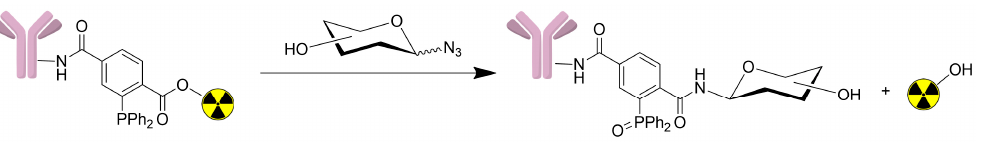
Figure 1. Strategy for blood pool clearance upon Staudinger ligation. The radiolabeled bioconjugate reacts chemoselectively with sugar azides to release radioactivity.